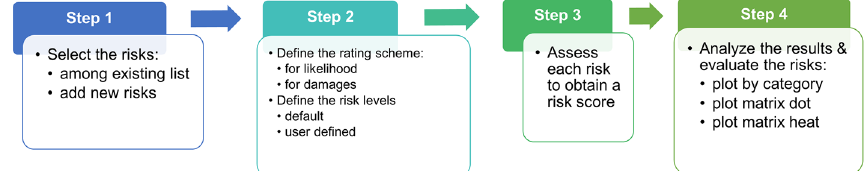
Fig. 1 Steps to perform to realize a risk analysis with the risk register tool. Each step corresponds to a different tab in the